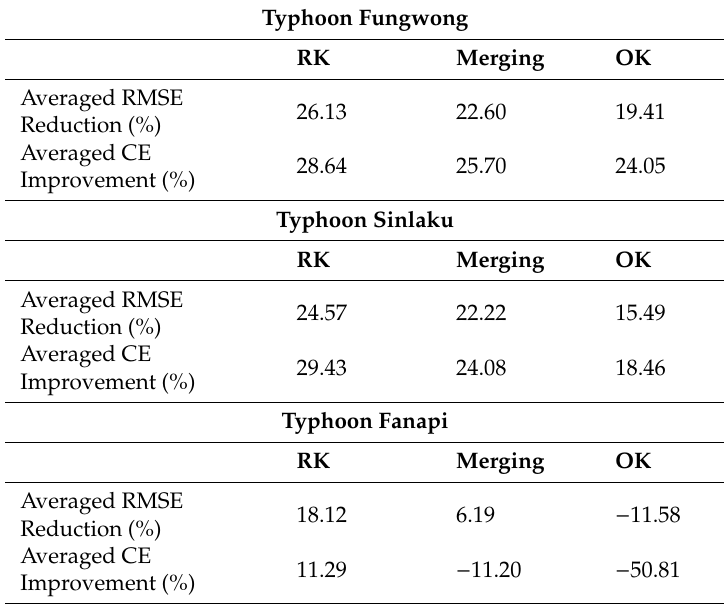
Table 7. Summaries of error analysis between RK, merging, and OK techniques for typhoons Fungwong, Sinlaku, and Fanapi. Typhoon Fungwong RK Merging